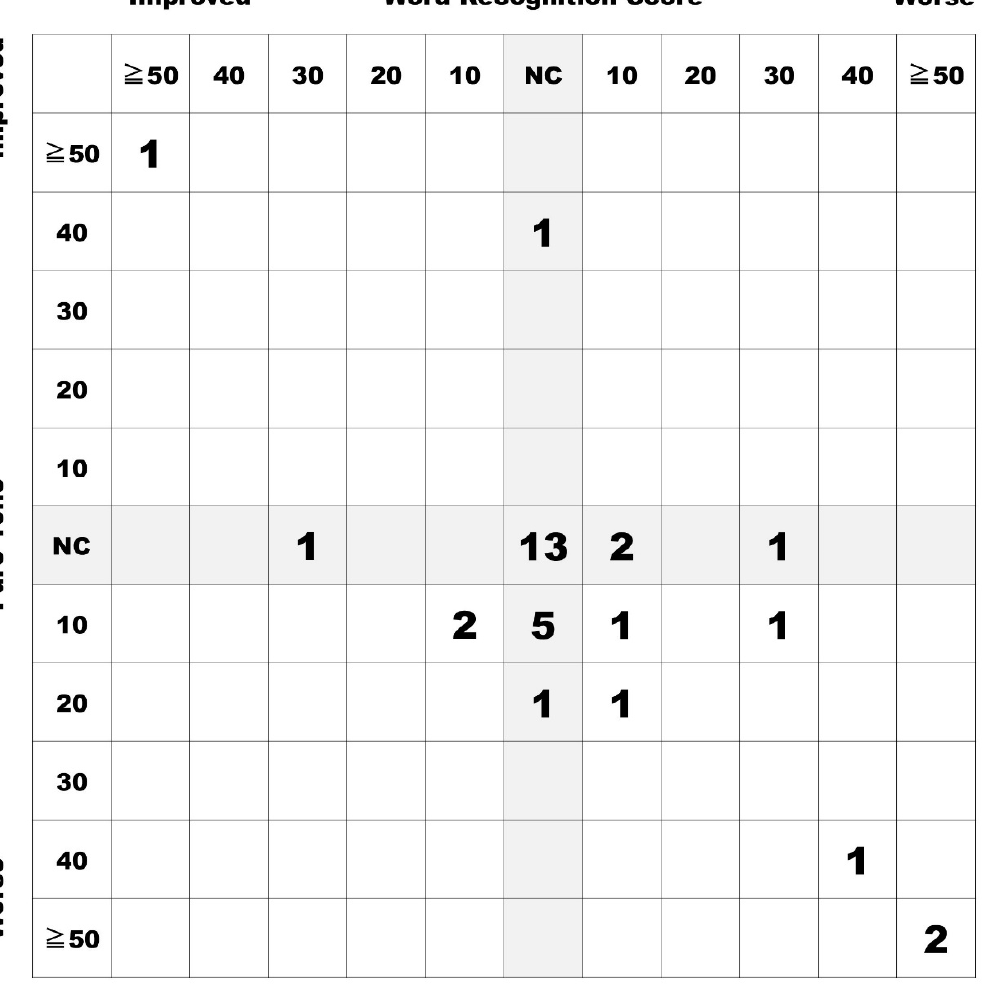
Figure 3. Postoperative hearing results of included cases in this study. In 26 of the 33 cases (79%), preservation of hearing was equivalent to that before surgery or improved hearing. Only two cases of deafness (6%) occurred after surgery. NC, No change.